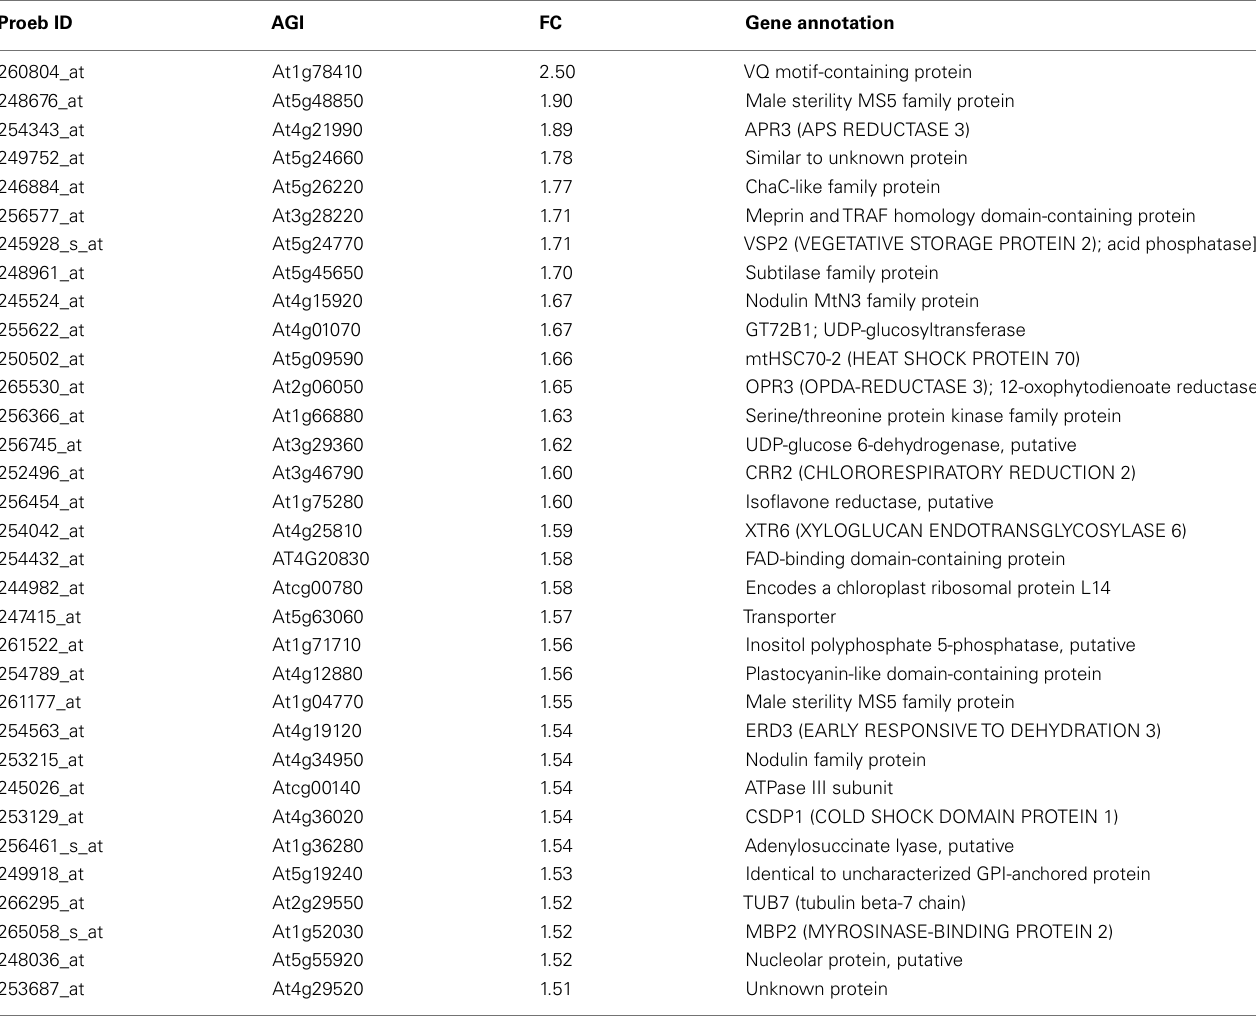
TableA3 | Expression values of up-regulated genes between control and SP-treated